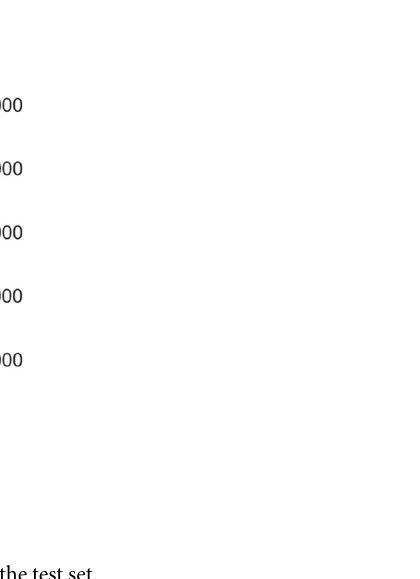
Figure 7. The confusion matrix of the model when applied to the test